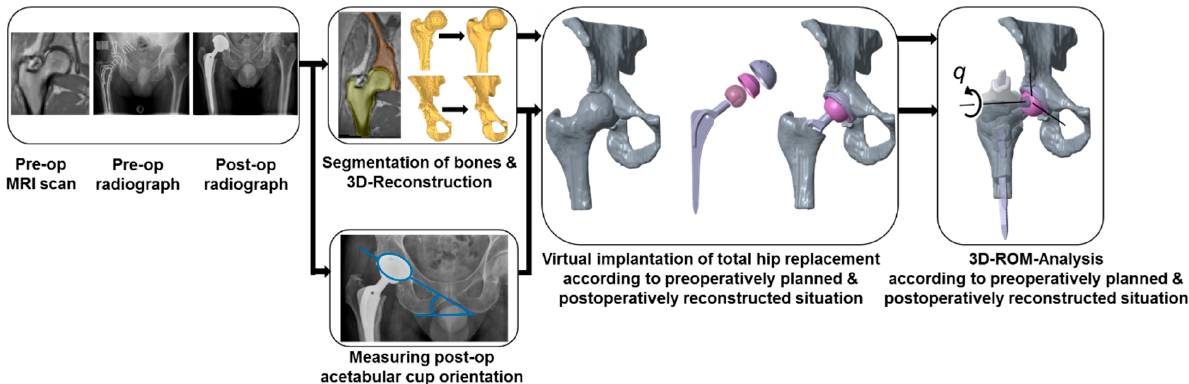
Figure 1. The computational framework for the preoperative calculation of the patient-specific range of motion (ROM) after subjection to virtually performed total hip arthroplasty. Note that the postoperative radiograph is solely used to generate the postoperatively reconstructed situation, which is intended to be used to compare the ROM with the preoperatively planned situation. Therefore, this is not necessary for the intended framework, i.e., the estimation of the postoperative ROM during preoperative planning based on MRI data.